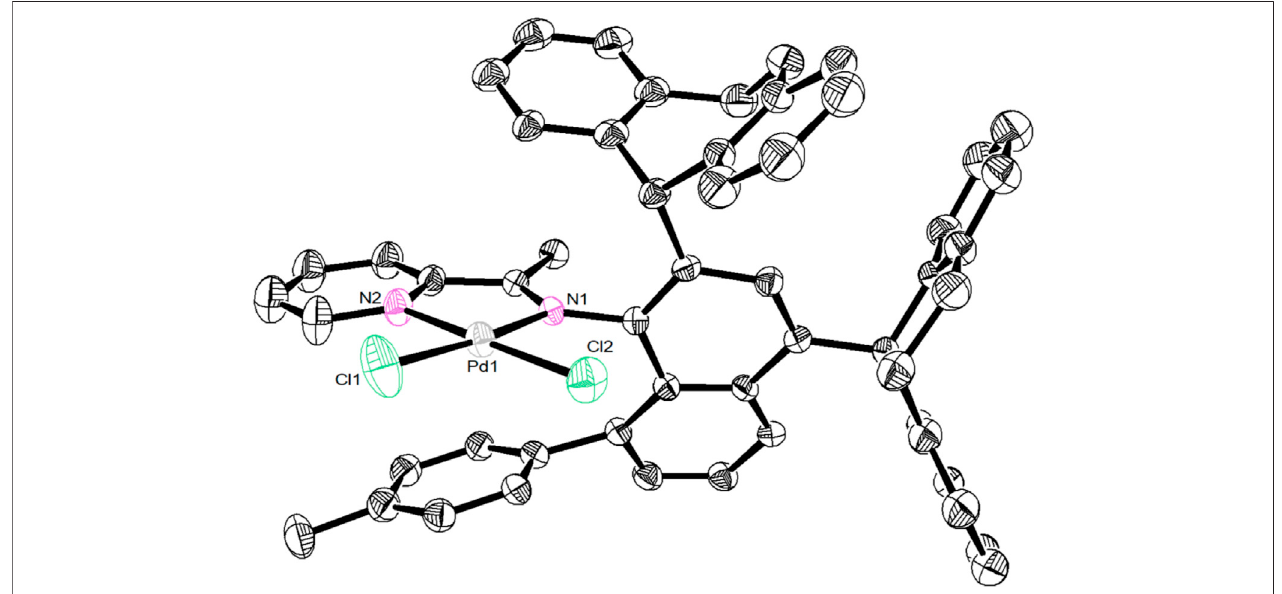
FIGURE 1 | Solid-state molecular structure of Pd5 (2150684) at the 30% probability level. All solvent molecules and hydrogen atoms are omitted for better clarity.